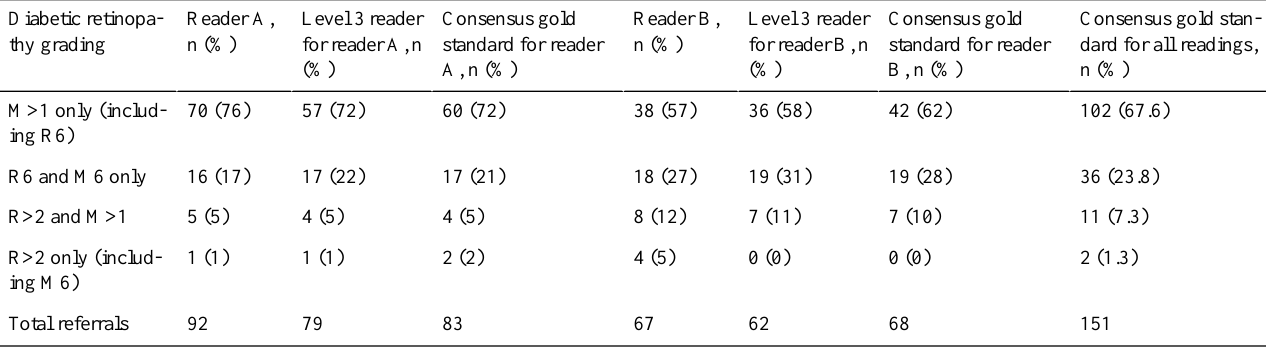
Table 1. Reasons for diabetic retinopathy referral in level 2 and level 3 readers and the consensus gold standard (N=559).